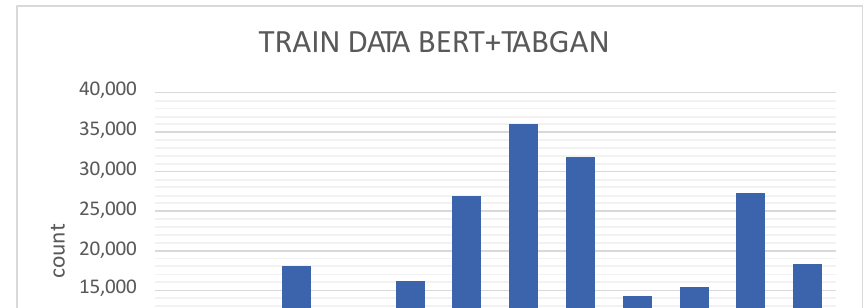
Figure 6. Training data for the BERT model.